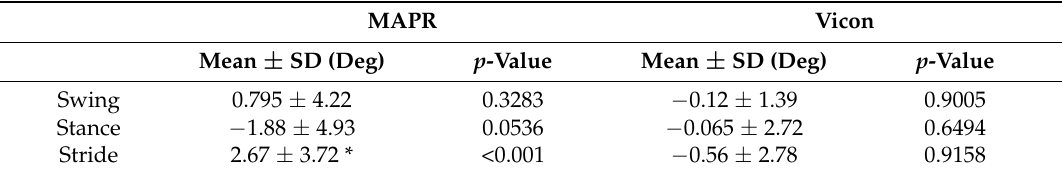
Table 3. Average value of angular displacement obtained by integrating knee angular velocity for inertial measurement units and optical motion capture systems. * significant difference.